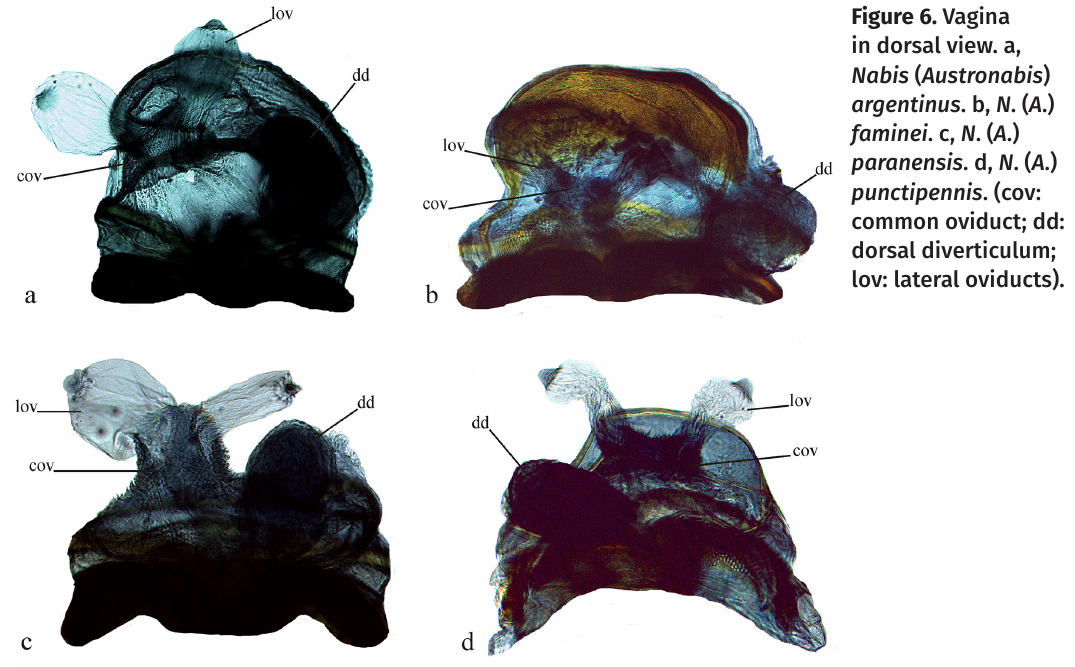
Figure 6. Vagina in dorsal view. a, Nabis ( Austronabis ) argentinus . b, N . ( A .) faminei . c, N . ( A .) paranensis . d, N . ( A .) punctipennis . (cov: common oviduct; dd: dorsal diverticulum; lov: lateral